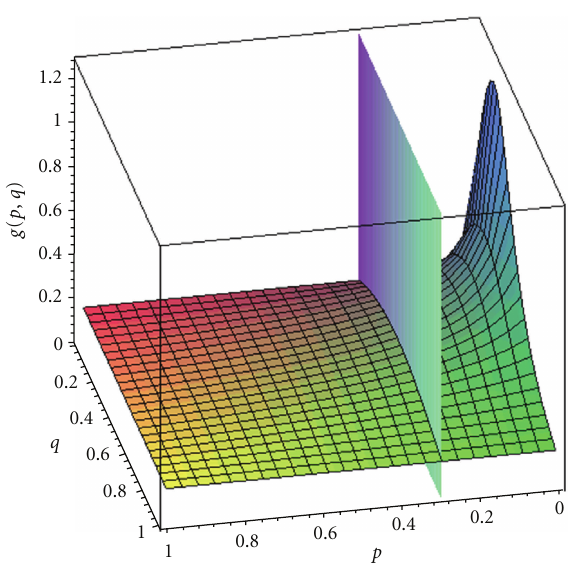
Figure 4: The function image of g ( p , q ).